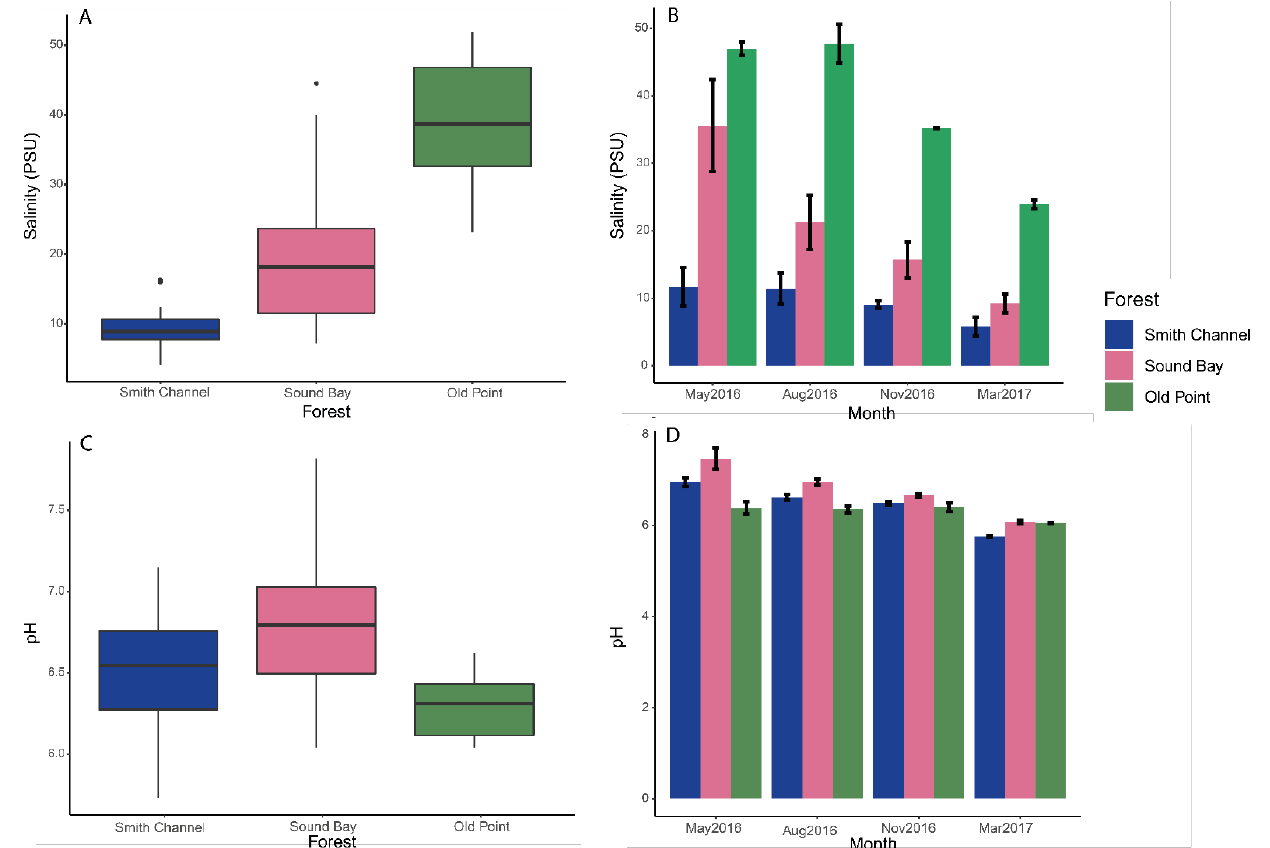
Figure 2. Interstitial salinity and pH in each of the mangrove forests. ( A ). Salinity grouped by forest; ( B ). Salinity for each forest and each time evaluated. ( C ). pH grouped by forest; ( D ). pH for each forest and each time evaluated. The bars indicate the standard error of each data group (SE).